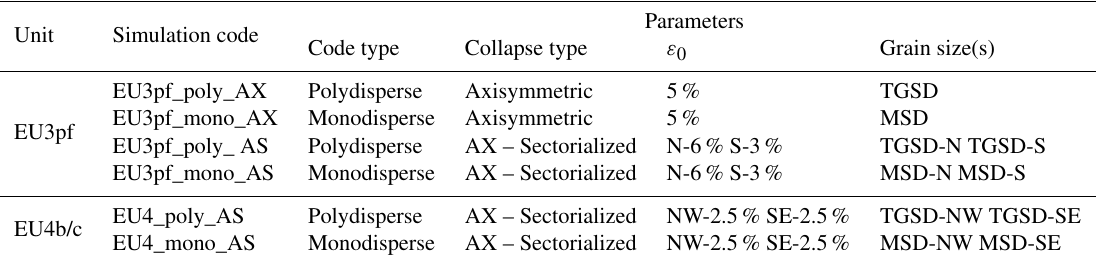
Table 4. PyBox simulations for the EU3pf and EU4b/c units. Symbol key: AX – “axisymmetric”; AS – “axisymmetric–sectorialized”; ε 0 – “volumetric fraction of solid